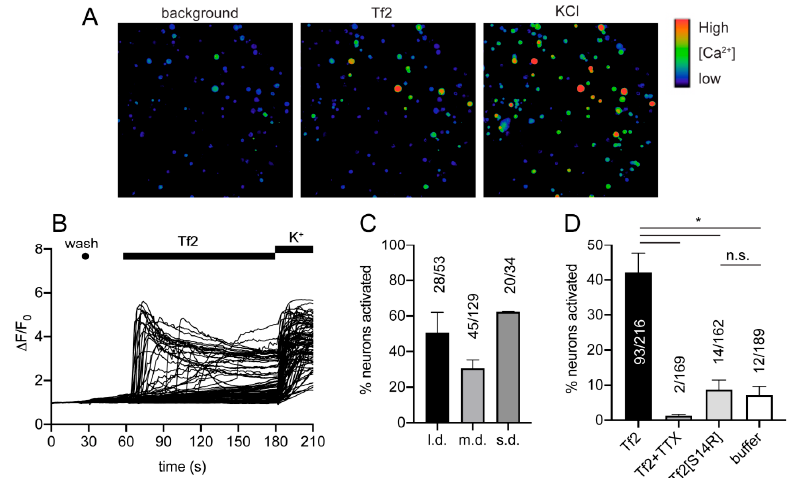
Figure 3. Tf2 activates mouse dorsal root ganglion neurons. ( A ) DRG cells before (background) and after the addition of 1 µM Tf2 and 30 mM KCl. ( B ) Traces from all neurons (defined as cells responding to 30 mM KCl and/or 1 µM Tf2) of one representative experiment. ( C ) Percentage of large (> 600 µm 2 ), medium (300–600 µm 2 ), and small diameter (< 300 µm 2 ) neurons activated in the presence of 1 µM Tf2. ( D ) Percentage of neurons (total) activated in the presence of 1 µM Tf2, 1 µM Tf2 + 1 µM TTX, 1 µM Tf2[S14R], or buffer (negative control). Data are presented as SEM with the total number of neurons from 2–3 independent experiments; l.d., large diameter, m.d., medium diameter; s.d., small diameter; K + , 30 mM KCl; *, p < 0.05 using unpaired t -test; n.s., not